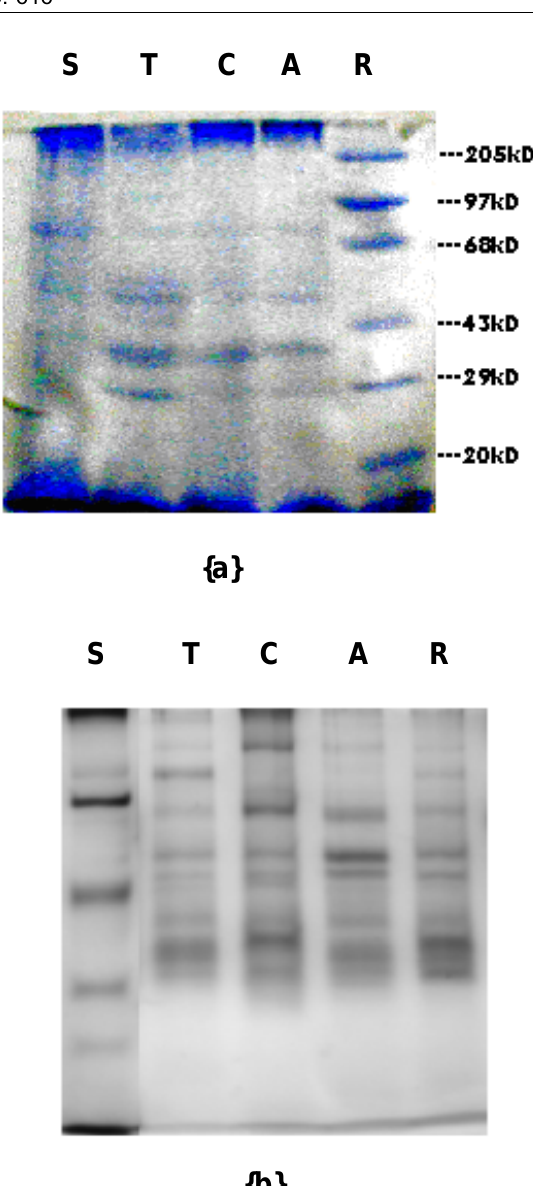
Figure 1: Electrophoresis pattern of red scorpion ( Mesobuthus tamulus ) venoms. {a} Electrophoresis using Coomassie blue staining {b} Electrophoresis using silver